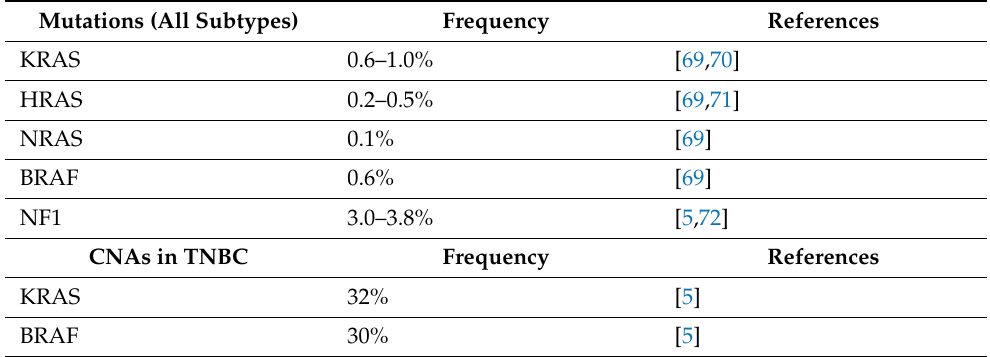
Table 2. Main RAS/RAF/MEK/ERK pathway driver alterations in primary breast cancer (data from